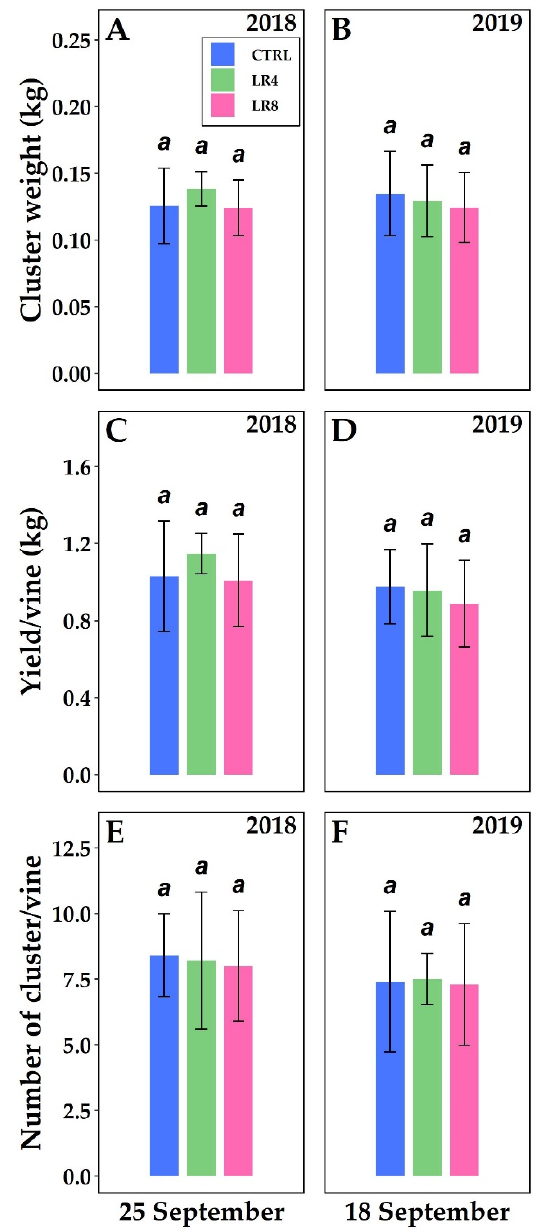
Figure 4. Cluster weight (kg) (( A ), 2018; ( B ), 2019), yield/vine (kg) (( C ), 2018; ( D ), 2019), and number of cluster/vine (( E ), 2018; ( F ), 2019) of V. vinifera with three different defoliation management: four leaf removal (LR4, green column), eight leaf removal (LR8, pink column), and no defoliation (CTRL, blue column). Measurements were conducted at full maturation (25 September 2018 and 18 September 2019). Different letters within the same parameter indicate significant differences. Data (mean ± SE, n = 10) were subjected to one-way ANOVA (LSD test, p ≤ 0.05).